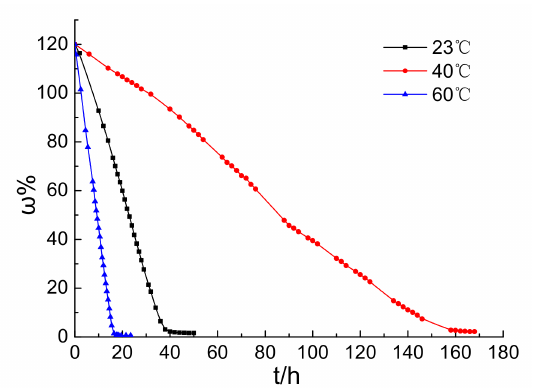
Figure 4. Change curve of water content and time of red clay with diameter of 60 mm.